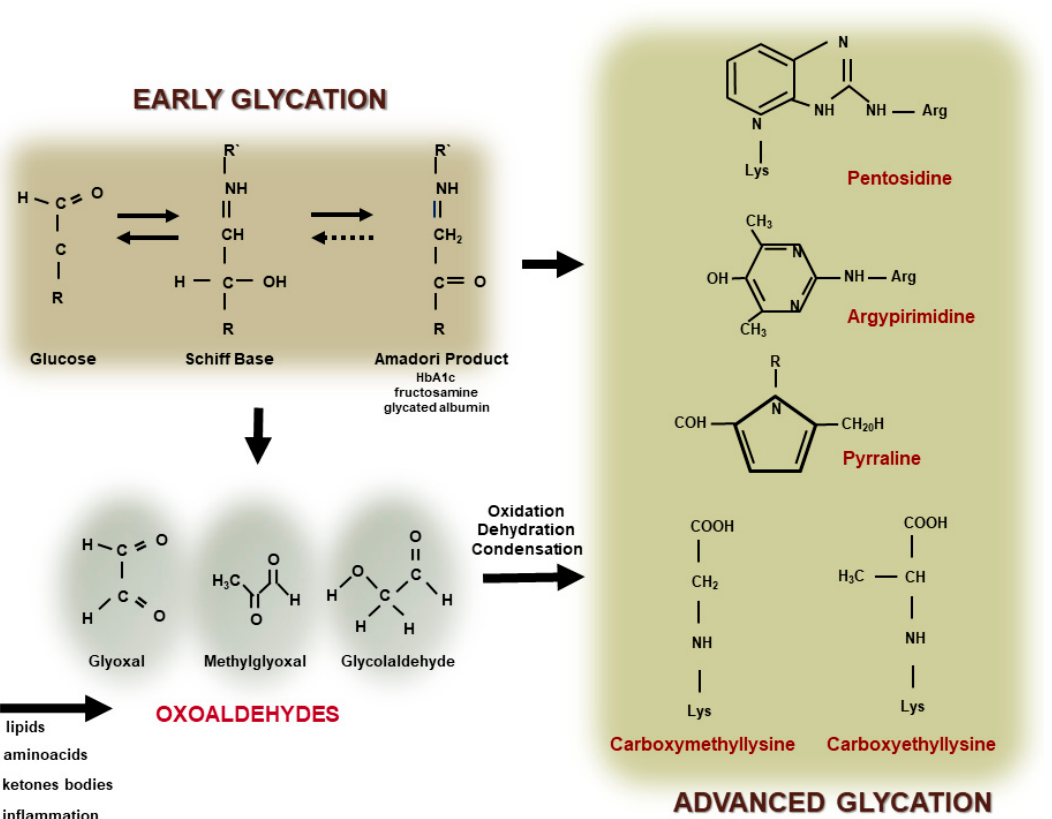
Figure 1. Advanced glycation end product (AGE) formation. The glycation reaction takes place by the modification of amino-terminal groups of proteins, phospholipids, or nucleic acids, by glucose or other monosaccharides leading to the generation of a Schiff Base and an Amadori product (early glycation). The auto-oxidation of glucose and rearrangements of the Schiff Base and the Amadori product, as well as the oxidation of amino acids, lipids or ketone bodies, and inflammation, promotes the generation of oxoaldehydes (such as glyoxal, methylglyoxal, and glycolaldehyde). They lead to the rapid and irreversible generation of AGEs, including heterogenous compounds, such as, pentosidine, argypirimidine, pyrraline, carboxymethyllysine, and carboxyethyllysine. Intracellular generated AGEs originate from the increased glucose flow through gly- colysis that favor the output of reactive oxygen species (ROS) from mitochondria and the DNA-repairing enzyme poly (ADP-ribose) polymerase (PARP). Although protecting DNA from ROS-induced damage, PARP promotes poly ribosylation of the glyceraldehyde 3-phosphate dehydrogenase (GAPDH), impairing its activity. Substrate deviation from glycolysis generates MGO and, as a consequence, AGEs are formed feeding a vicious circle by inducing oxidative stress [13,14]. Hyperglycemia also induces the activation of the hexosamine, polyol and protein kinase C pathways, exacerbating the intracellular oxidative stress, which perpetuates the AGE generation [13,15] (Figure